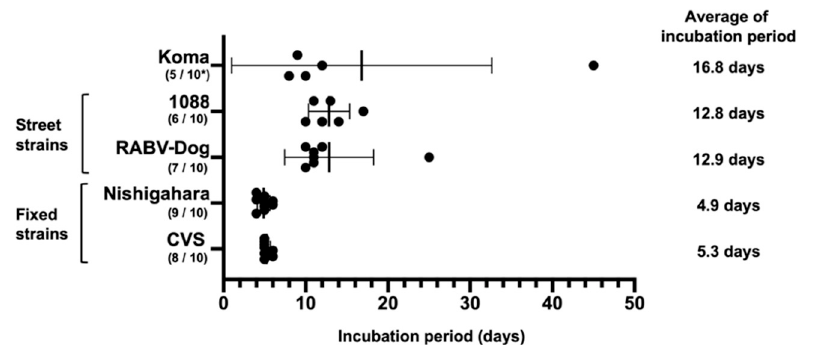
Figure 7. Incubation periods in mice infected with virus strains via the i.m. route. Six-week-old male mice (10 mice/group) were inoculated intramuscularly with 3.0 LD 50 of each of the strains into the left thigh muscle and were observed daily for 50 days. Each column represents the date of onset of disease in each mouse (mean ± standard deviation). *, number of sick/inoculated mice .